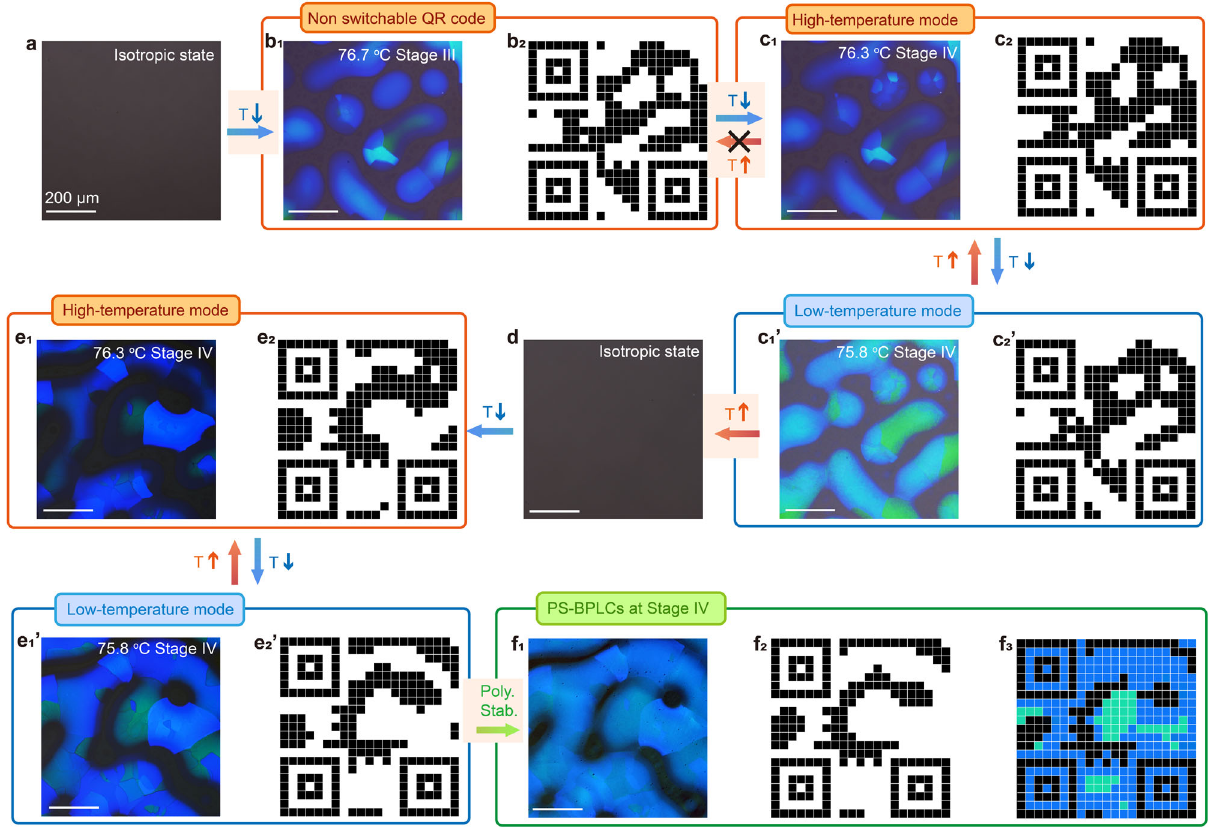
Fig. 6 Ternary anti-faking temperature-switchable QR codes. a The initial isotropic state. b 1 The randomly distributed BPIII domains and con fi gurations of BPIII/BPII, BPIII/BPI, and BPIII/BPII/BPI in Stage III are obtained at 76.7 °C. b 2 The corresponding binary QR code transferred from b 1 . c The BPIII/BPII/BPI core-shell con fi gurations in Stage IV obtained at c 1 76.3 °C and c 1 ’ 75.8 °C in the fi rst cooling process. c 2 , c 2 ’ The corresponding binary QR codes transferred from c 1 , c 1 ’ . d The isotropic state in the second cooling process. e 1 , e 1 ’ The BPIII/BPII/BPI core-shell con fi gurations in Stage IV observed at e 1 76.3 °C and e 1 ’ 75.8 °C. e 2 , e 2 ’ The corresponding binary QR codes transferred from e 1 , e 1 ’ . f 1 The BPIII/BPII/BPI core-shell con fi gurations with high thermal stability by polymer-stabilizing the textures in low-temperature mode e 2 . f 2 – f 3 The binary and ternary QR codes transferred from the POM image f 1 using the same methods shown in Fig. 5. “ Poly. Stab. ” refers to “ polymer stabilization ” .